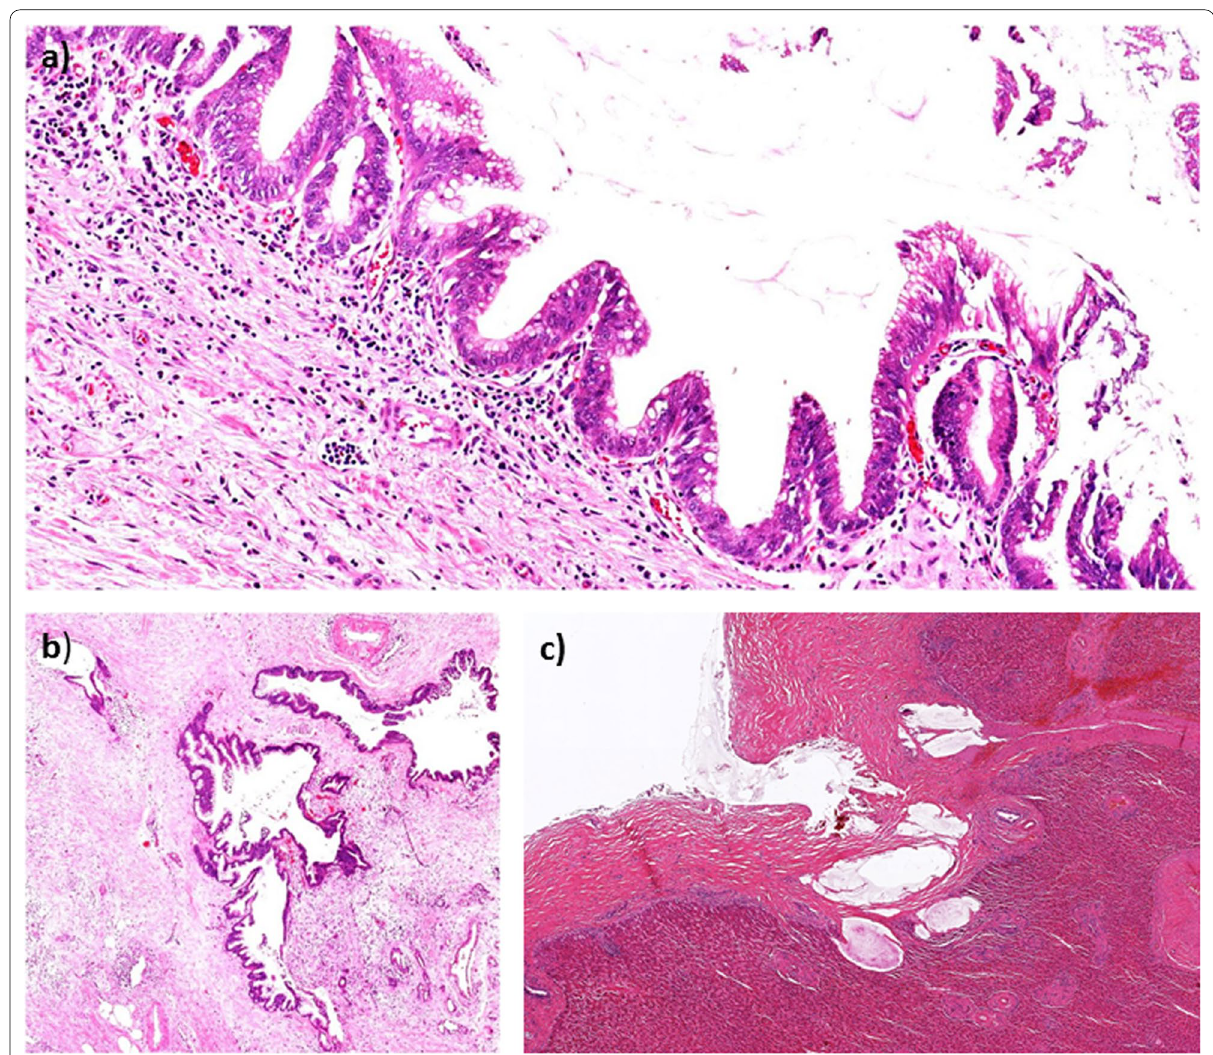
Fig. 3 Microscopic pathology. a Lesions with nuclear stratification and some degree of atypia, which is equivalent to peritoneal mucinous carcinomatosis, are observed. b The mucinous tumor invaded the pancreatic parenchyma destructively. c A mucinous lake is observed in the liver